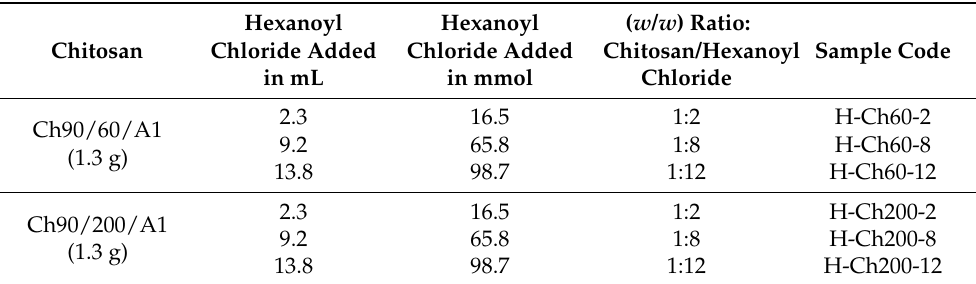
Table 1. Overview of the reaction parameters which were varied in order to obtain the different types of modified chitosan samples (H-chitosan). Hexanoyl Hexanoyl Chitosan Chloride Added Chloride Added Chitosan/Hexanoyl Sample in mL Chloride